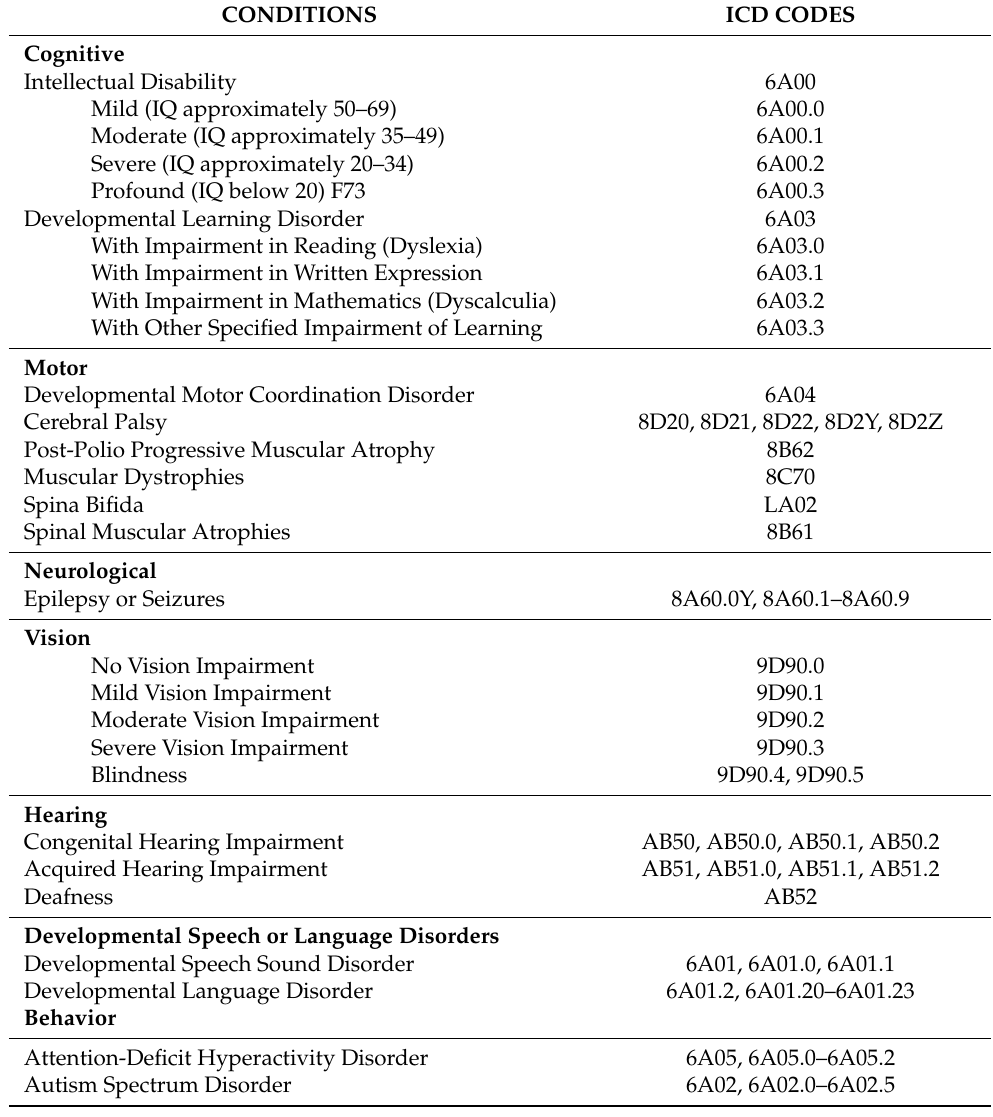
Table 1. Major Categories of Developmental Disability with Corresponding ICD-11 Diagnostic